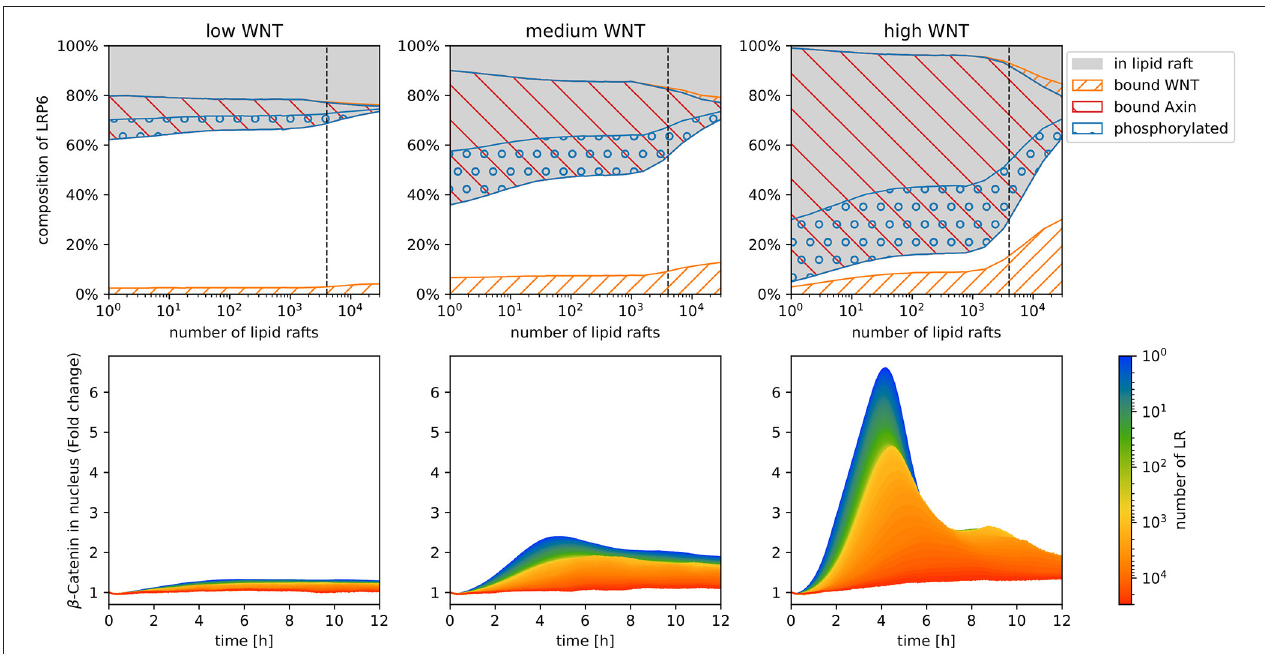
FIGURE 3 | Simulation results of the model displayed in Figure 2 , with increasing raft numbers and with three different WNT stimuli: high, medium, and low. In the upper row the composition of LRP6 states after 12 h of stimulation is depicted for each WNT stimulation scheme. Depicted are raft-associated (gray), phosphorylated (blue circles), WNT-bound (orange stripes), and Axin-bound (red stripes) LRP6 molecules. Note that in the stacked area chart of the upper row, the amount of bound and phosphorylated LRP6 are displayed separately for non-raft (lower area, white background) and raft (upper area, gray background) domains and have to be added/summed up to obtain the total number of each receptor state. The lower row illustrates the fold change of β -catenin concentration in the nucleus [compared to the initial number of β -catenin in the nucleus (nbetanuc)] during 12 h of constant WNT stimulation for increasing numbers of lipid rafts. Each colored line represents the mean trajectory of several simulation runs (replications) of our model parameterized with the corresponding lipid rafts amount (encoded in the